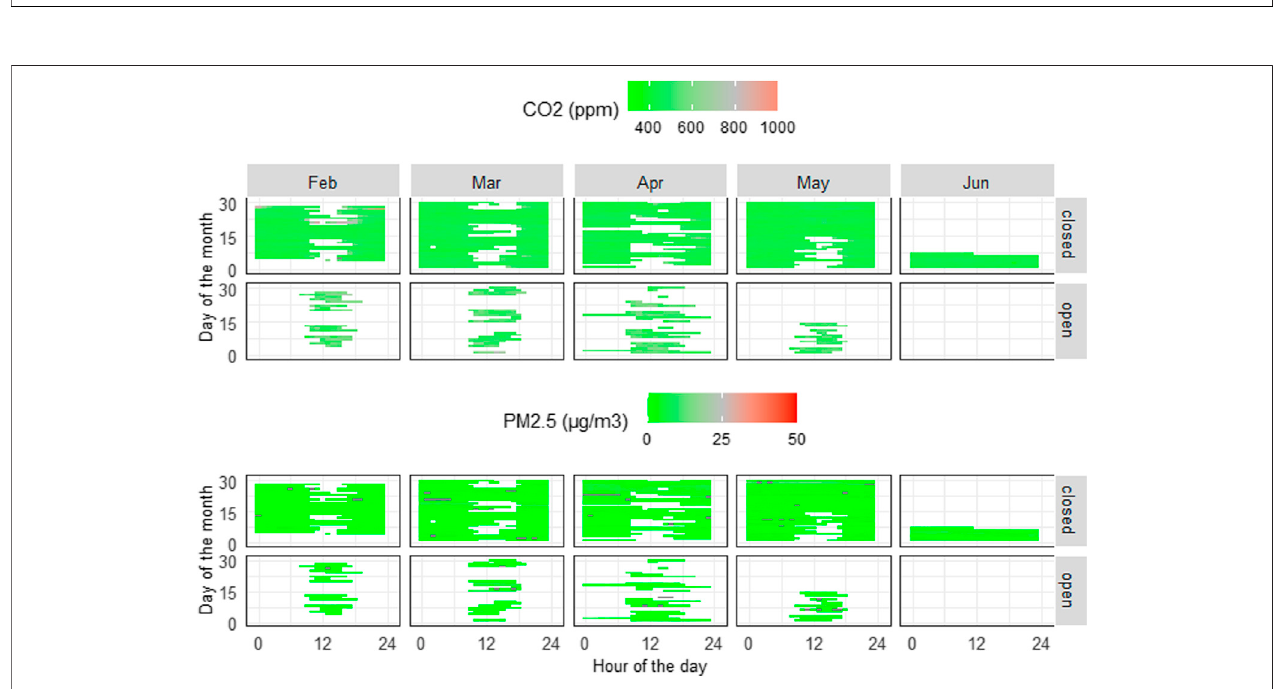
FIGURE 12 | NV example: room